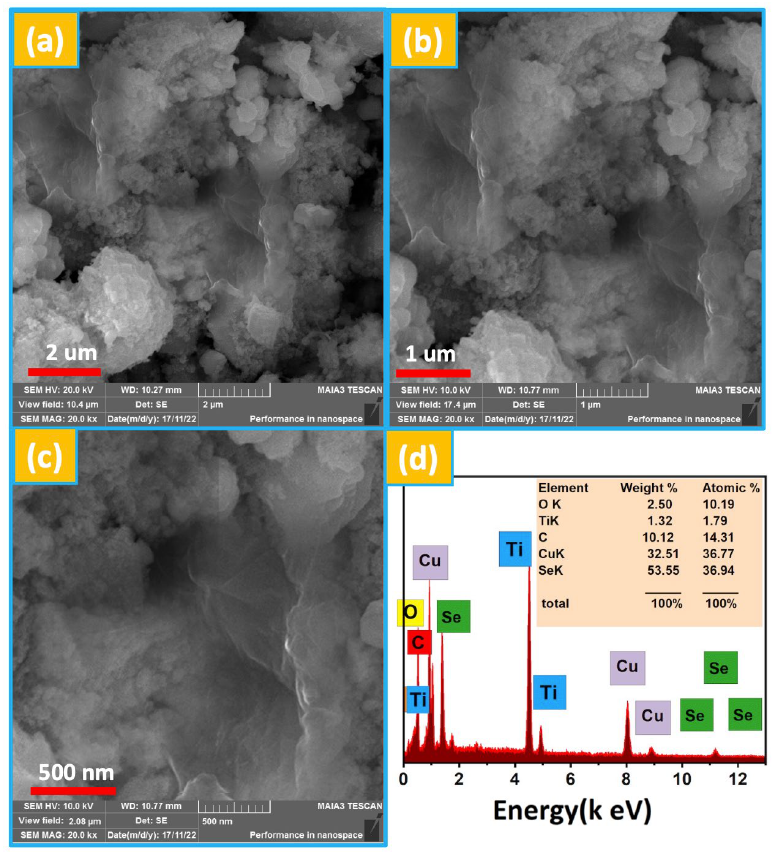
Figure 3. ( a – c ) Morphological analysis of the sample by the FESEM diagram at different scale bars, ( d ) EDX spectrum of the CuSe-TiO 2 -GO nanocomposite.